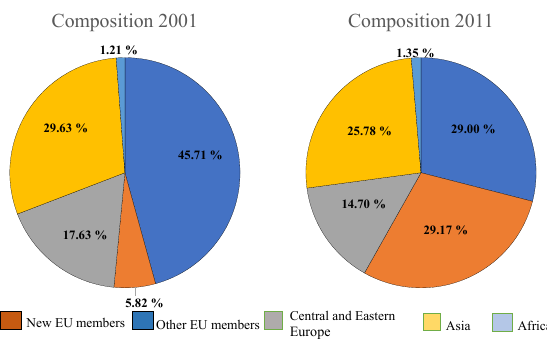
Figure 6. Composition of the foreign population in study area by group of origin, 2001–2011. Source: 2011 Population Census, Cys- tat. Own